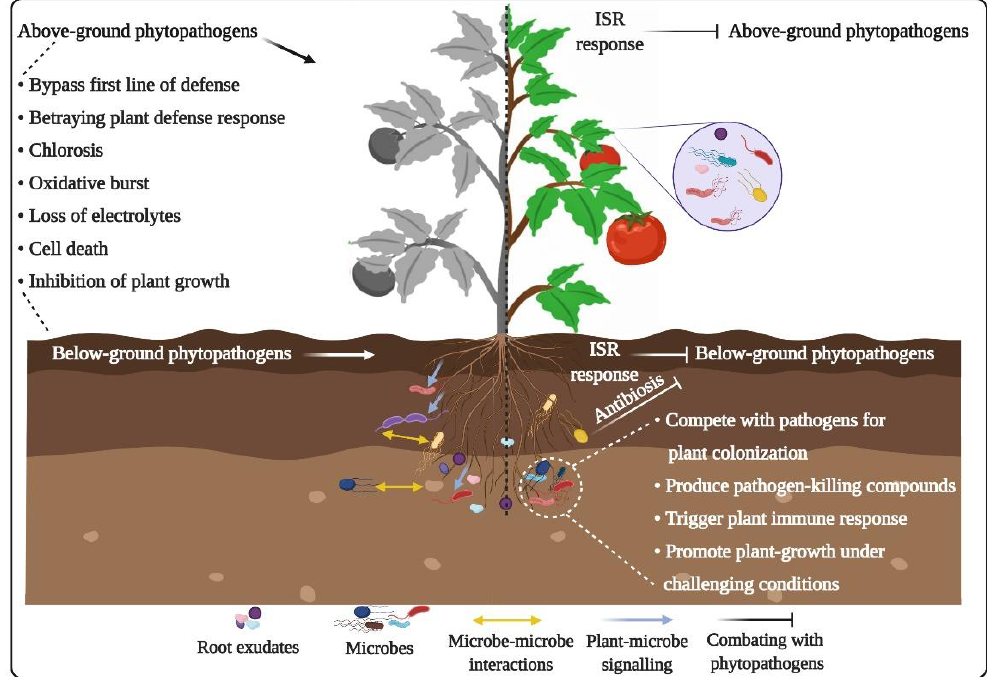
Figure 3. Beneficial impacts of positive plant–microbe interactions on plants. In plants, pathogen-oriented molecular patterns (i.e., PAMPs) or plant-beneficial bacteria activate induced systemic resistance (ISR). Positive interactions between plant and microbiome help plants in combating diseases and other environmental stresses, as well as boosting growth and biomass production. Beneficial plant-microbiota compete with phytopathogens for colonization, resources, and habitat, etc. Overall, beneficial microbes, through numerous mechanisms, including antibiosis, toxin production and nutrient sequestration, directly suppress the proliferation of pathogens and the symptoms of infections in